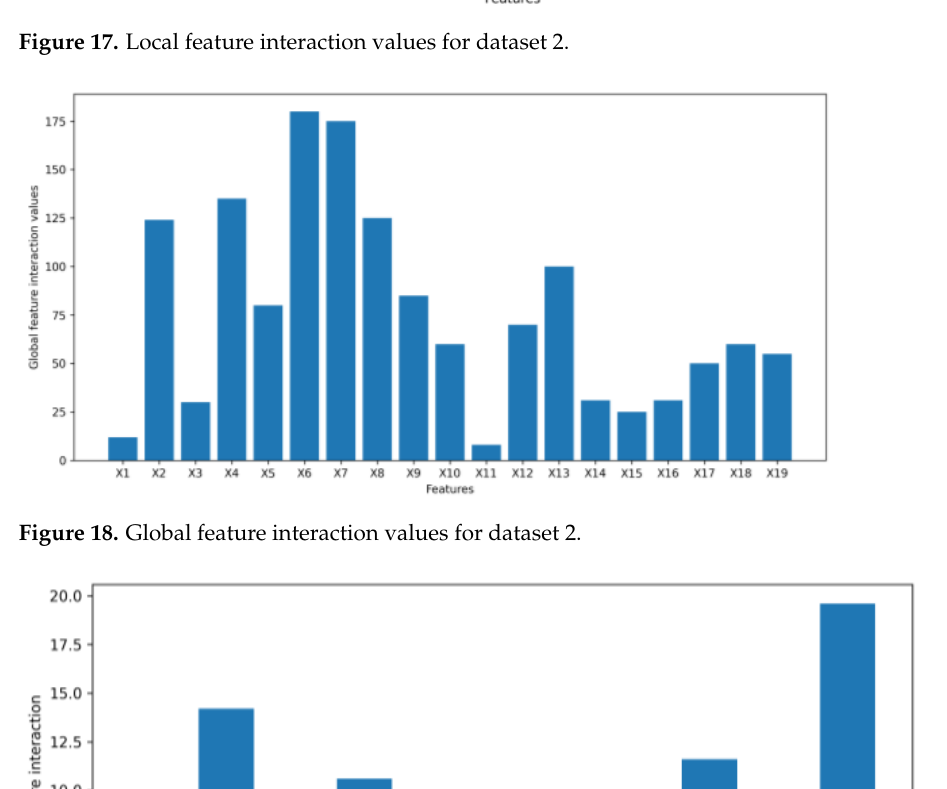
Figure 17. Local feature interaction values for dataset 2.